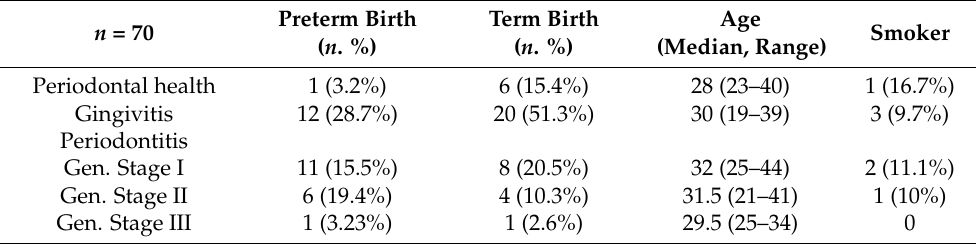
Table 3. Periodontal diagnosis according to birth outcome.